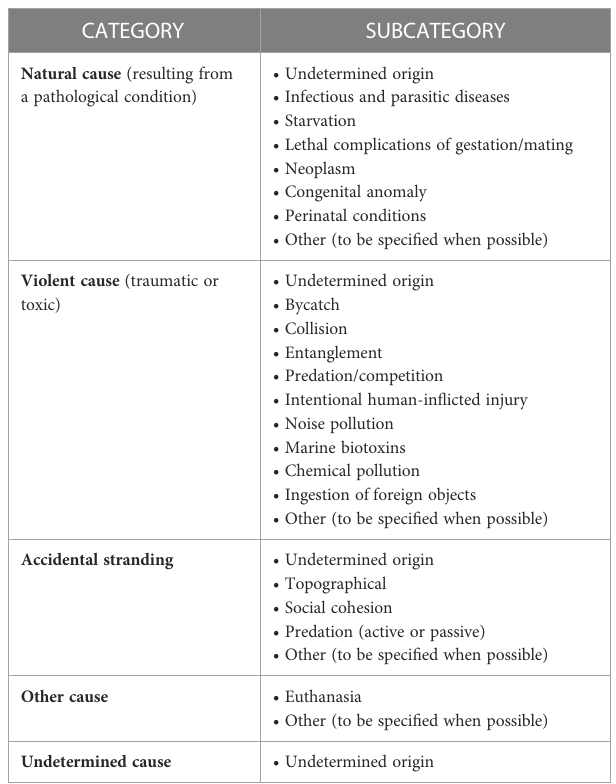
TABLE 3 Categories and sub-categories of initial causes of